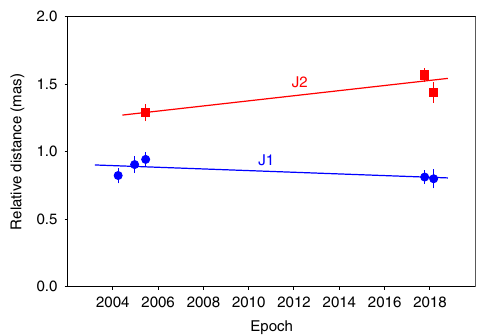
Fig. 3 Radial distance of J1 and J2 as a function of observing time. The straight lines (blue line for J1 and red line for J2) represent a linear regression fi t to infer the jet proper motion. The denoted error bars on each point are the 1 σ errors (see Table 1). That gives μ (J1) = − 0.006